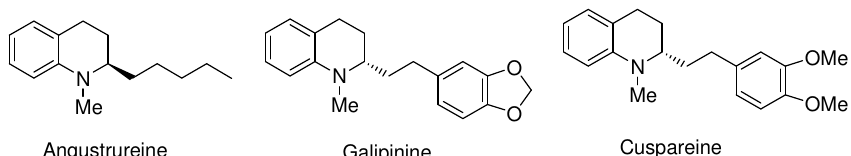
Figure 1. Some naturally occurring chiral tetrahydroquinolines.